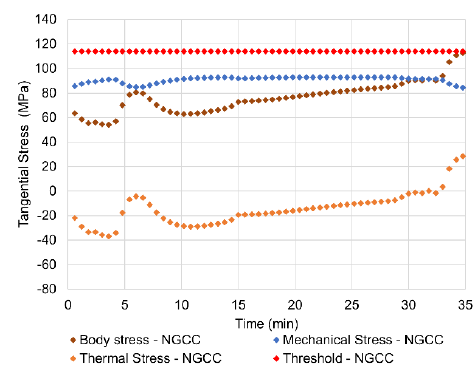
Figure 21. Mechanical and thermal stresses for NGCC: Case 5.